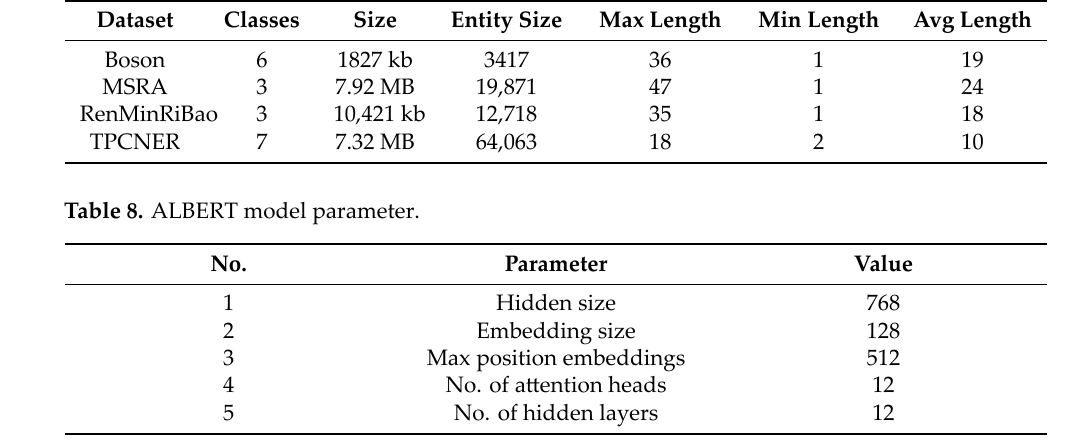
Table 7. Comparative information between TPCNER and other datasets.